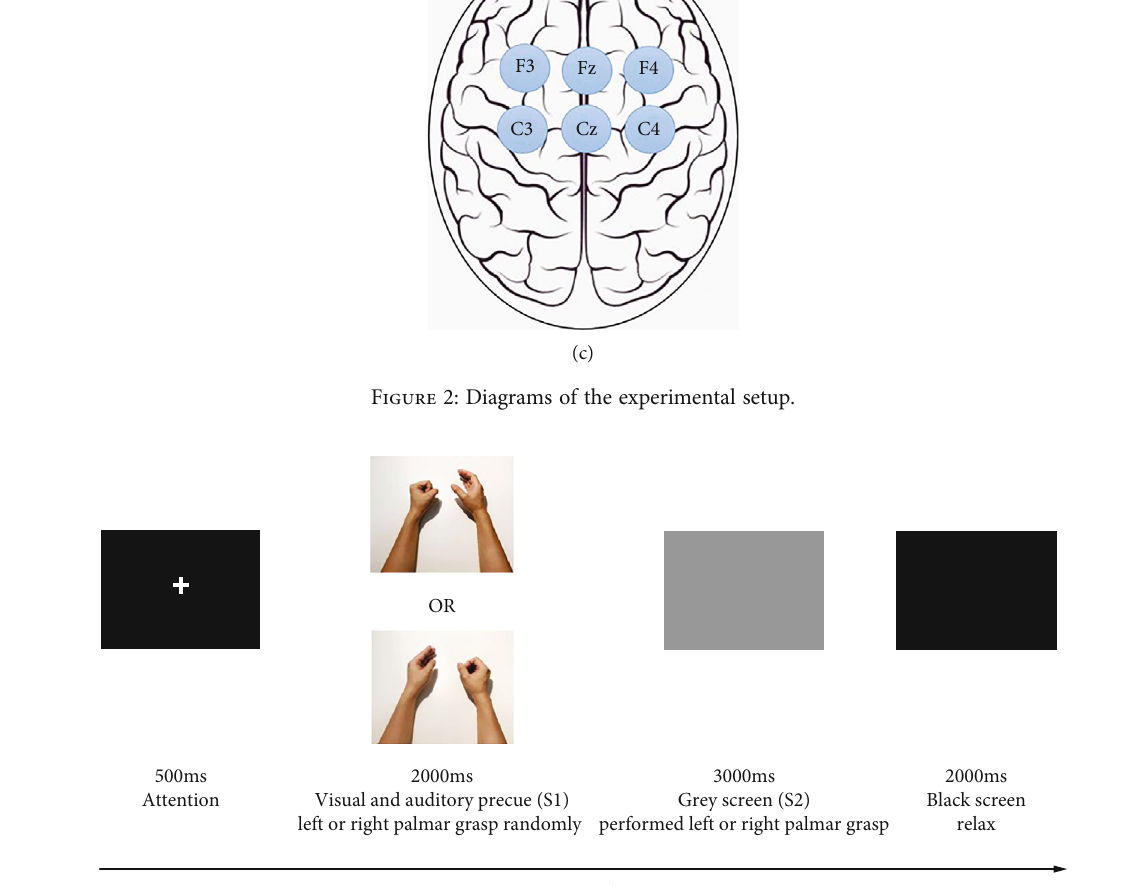
Figure 3: The ERP experiment